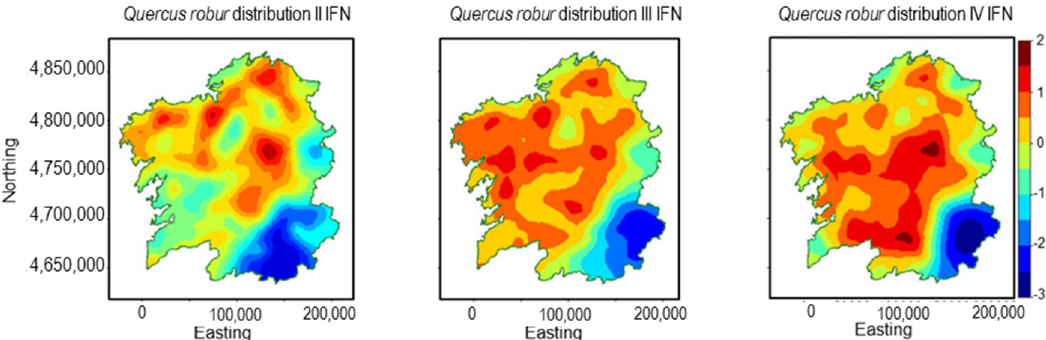
Figure 9. Maps of the posterior mean of the spatial field from the spatial model of Quercus robur , II, III, and IV forest inventories (coordinates in m.).